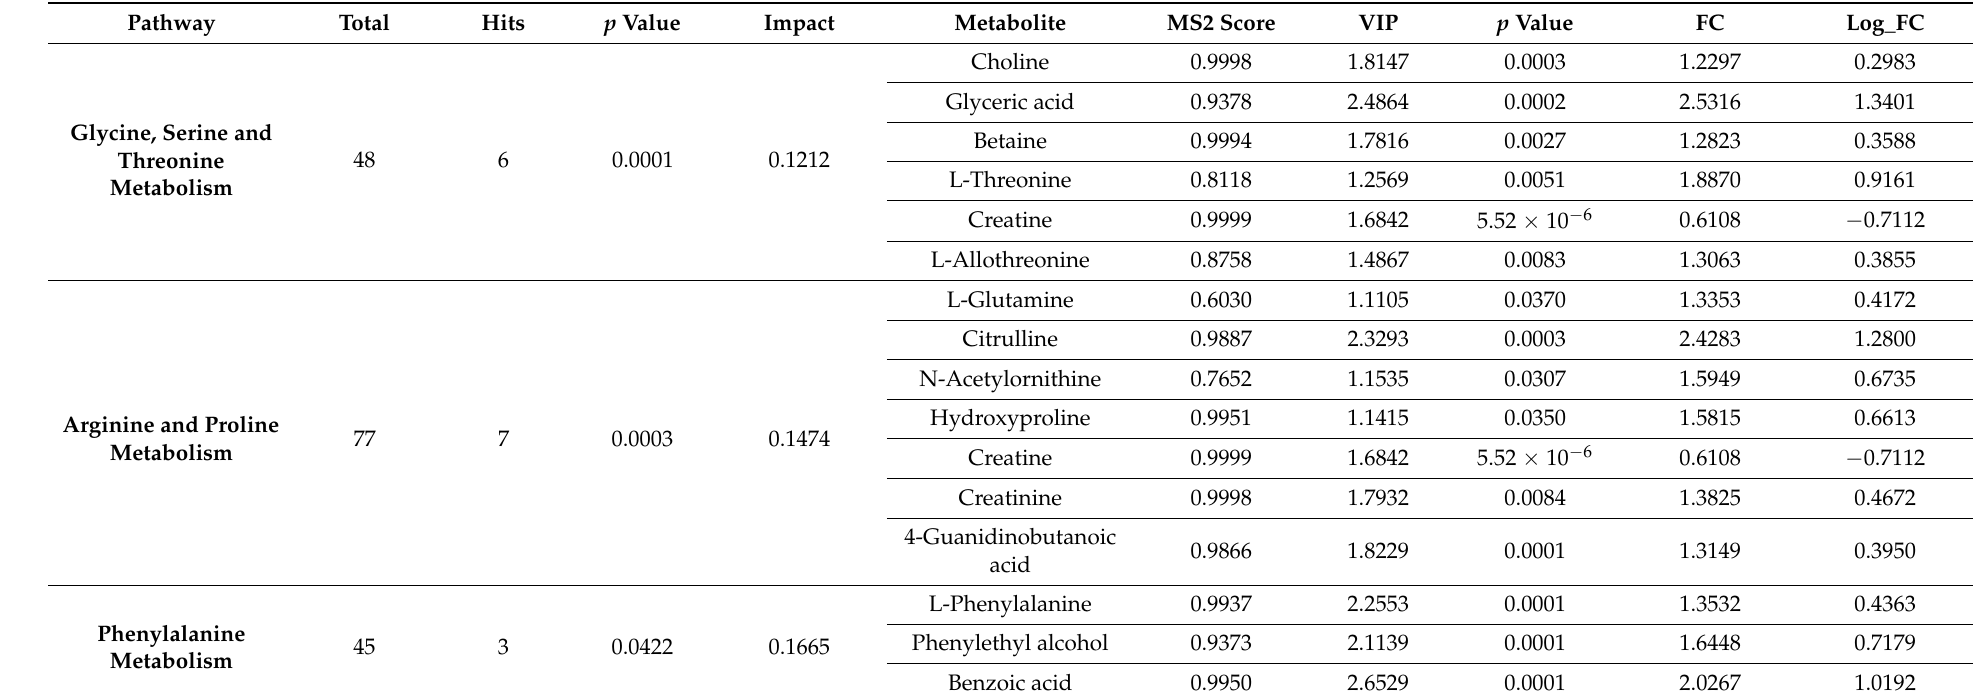
Table 2. The dysregulated metabolites in several amino acid metabolic